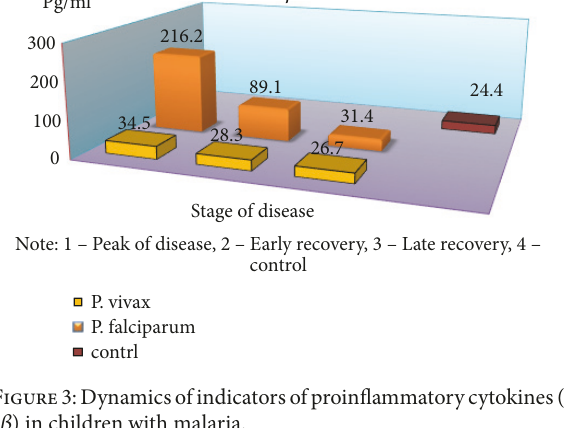
Figure 2: Dynamics of indicators of proinflammatory cytokines (TNF- 𝛼 ) in children with malaria.